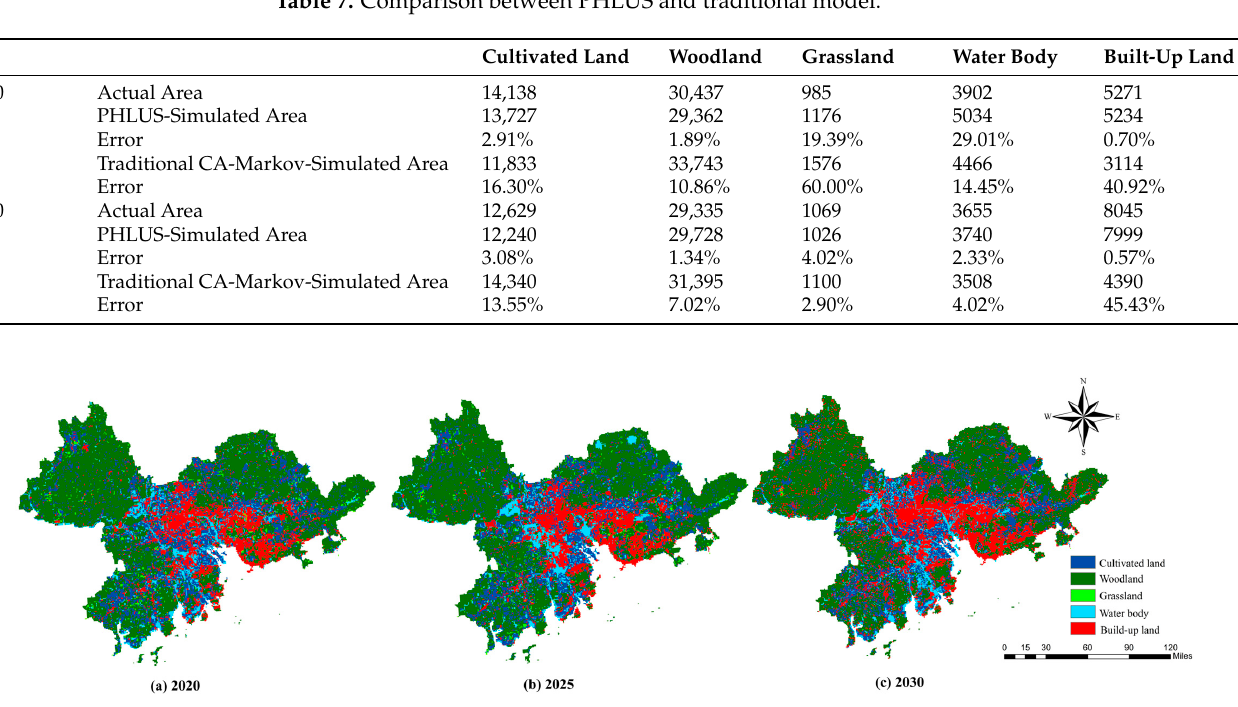
Figure 7. Sankey map of land-use change transfer from 2020 to 2030. 4. Discussion This study simulated land-use change in 2010 and 2020 on the basis of PHLUS and traditional CA-Markov model. The results show that the PHLUS significantly improves the simulation accuracy of land-use change. The model uses a partitioned approach to consider the effects of spatial heterogeneity on land-use change. In the current CA-Mar- kov land-use change studies, the formation of suitability atlases for each land-use type is influenced by spatial variables. The driving factors selected are mostly natural and social factors, and the influence of economic factors on land-use change is usually ignored. How- ever, economic and policy factors are often important drivers of urban development. There are important implications for changes in the spatial structure of land [52]. On the basis of existing studies, this study selected representative socio-economic factors that can reflect regional characteristics as driving factors, such as GDP and nighttime lighting data. The accuracy and realism of the simulation study of land-use change are improved. At present, partitioning the study area and developing different transition thresholds for conversion are the mainstream means to address this issue in the study of spatial hetero- geneity of land-use change. The division of the study area and the determination of the